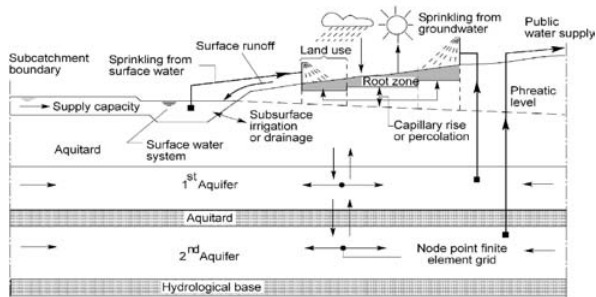
Fig. 2. Schematization of water flow in SIMGRO